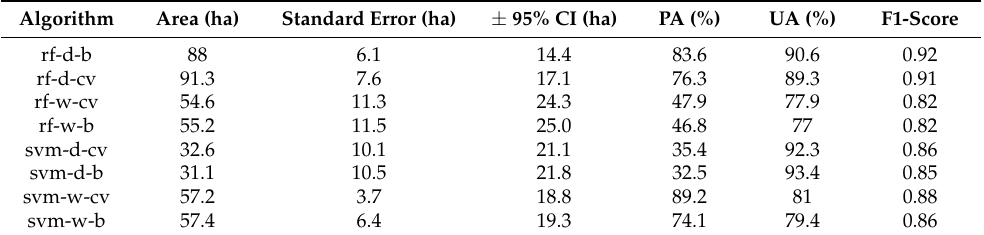
Figure 6. Unbiased user’s accuracy and producer’s accuracy (rf: random forest, svm: support vector machine, w: wet season, d: dry season, cv: cross-validation, b: bootstrapping, blue dashed line is 70% accuracy benchmark). Table 3. Estimated gully area (ha) with associated standard error (ha) at ± 95% CI (ha) for each algorithm (rf: random forest, svm: support vector machine, d: dry, w: wet, b: bootstrapping, cv: cross-validation, CI: confidence interval).